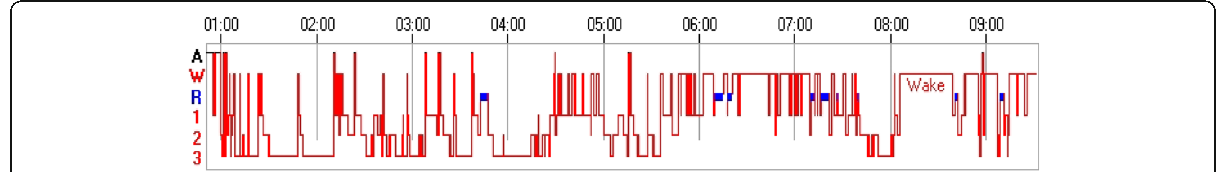
Fig. 2 Hypnogram of a Gullian Barré patient showing increased waking after sleep onset and sleep stage transition index with shortened rapid eye movement sleep (R) and N2 non-rapid eye movement sleep